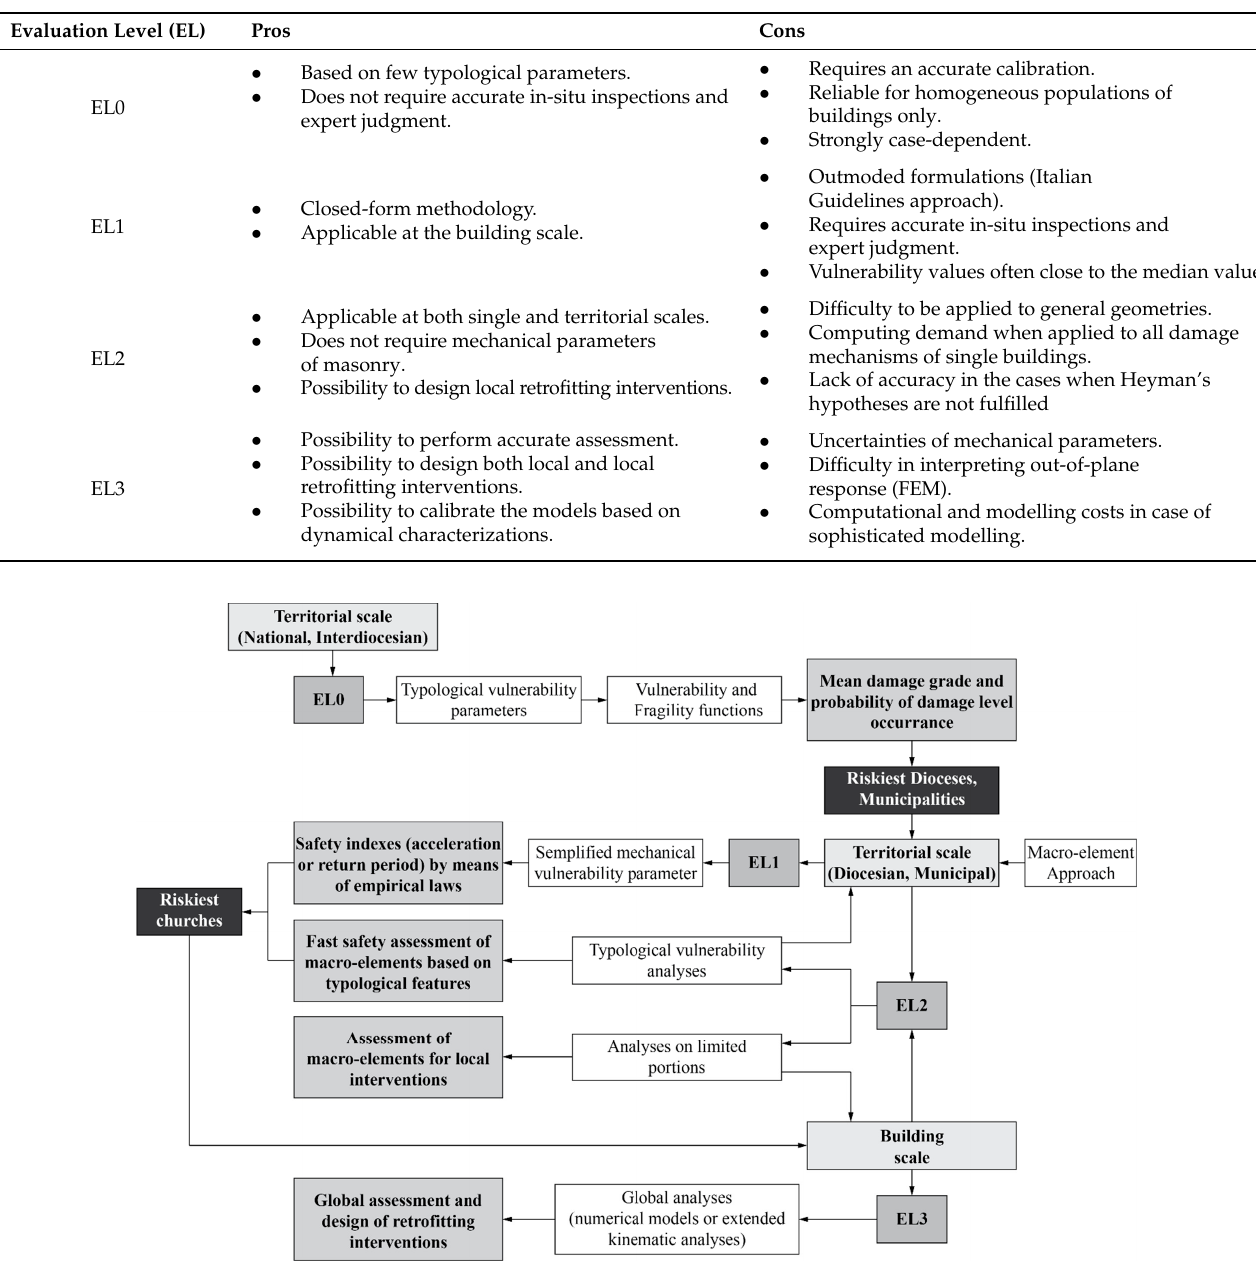
Table 7. Pros and cons of different detail level of assessment.